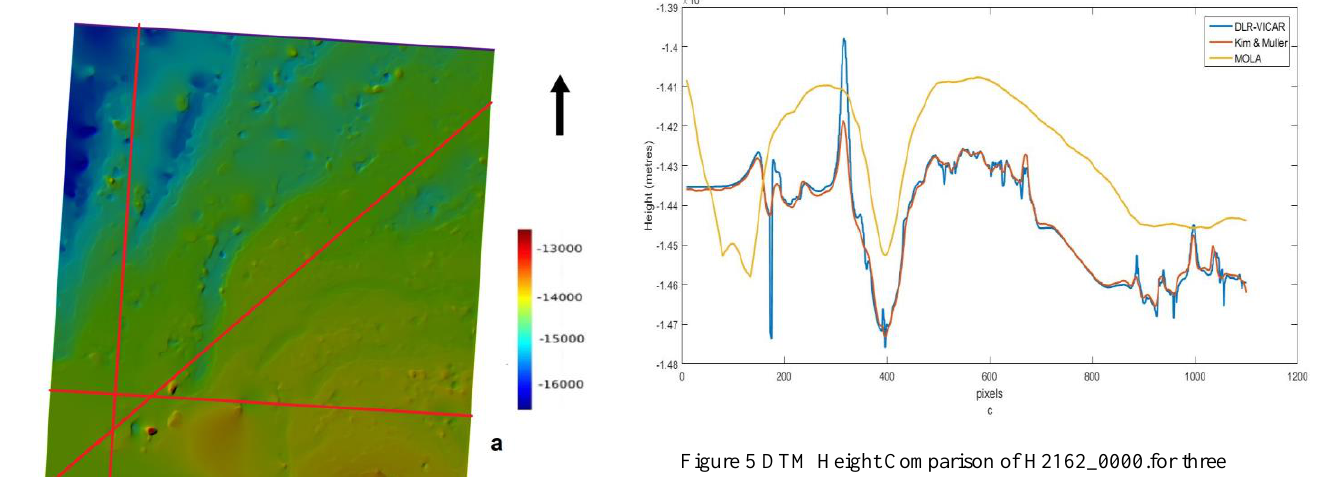
Figure 5 DTM Height Comparison of H2162_0000.for three height profiles Height profiles were extracted using values obtained in DTM. Height samples are taken for three different height profiles. The resulted DTM from Kim and Muller modified method gives a smoother profile, as seen in the side-by-side comparison between the DTM in Figure 4 and Figure 5 . Based on the height profiles in Figure 5 , we can see that the height profile is fairly similar for both processing, with smoother profile reached by Kim & Muller modification, reducing the outliers in height profiles obtained by DLR-VICAR method. Both processing are giving similar profiles with MOLA height values, with result from Kim & Muller modified method gives consistently lower height compared to MOLA height values compared to DLR- VICAR method which gives more fluctuative value. This can be corrected by giving adjustment for the height value. Better result can also be obtained by choosing profiles in accordance with MOLA orbits, not values based on interpolation. The height difference of HRSC DTM processing with MOLA height in the strip for Kim and Muller modified method can be seen in Figure 6 . As discussed in the previous part, difference compared to MOLA height values are pretty consistent for the image, with difference in +100 m range in most pixels. Higher differences are obtained around the SPRC edges. These differences might be caused by the need for MOLA footprints to have slopes <2º where even though the footprints are 170m, they do not represent the height discontinuities on the